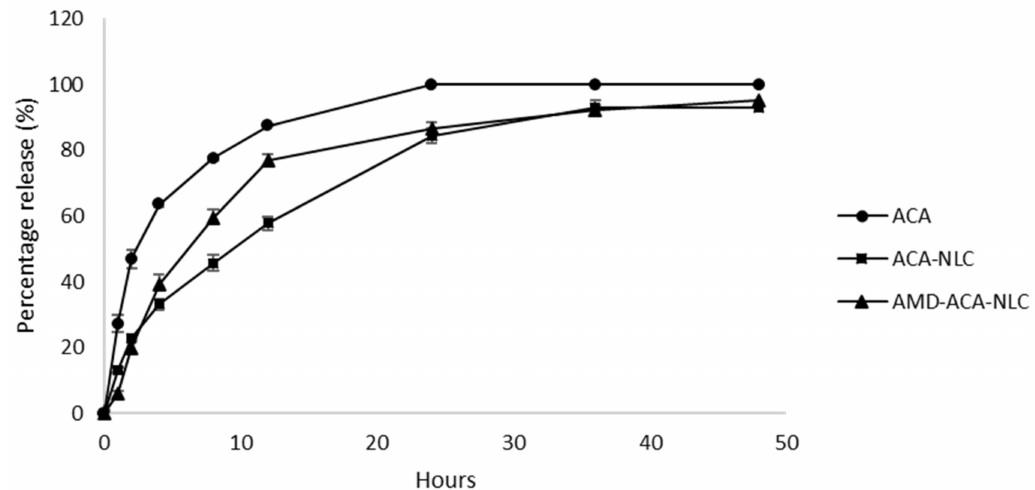
Figure 3. In vitro drug release profile of free ACA, ACA-NLC, and AMD-ACA-NLC solutions over 48 h of incubation at 37 ◦ C. All data are shown as mean ± S.D. of three